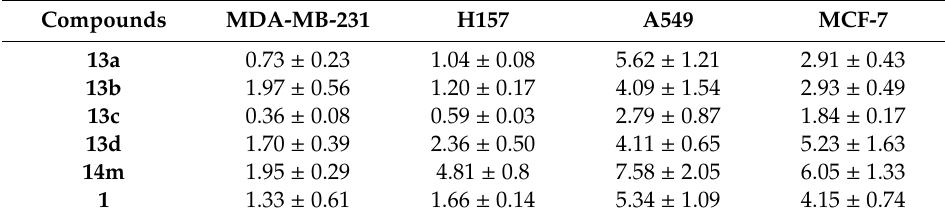
Table 2. IC 50 values ( µ M) of representative compounds against four cancer cell